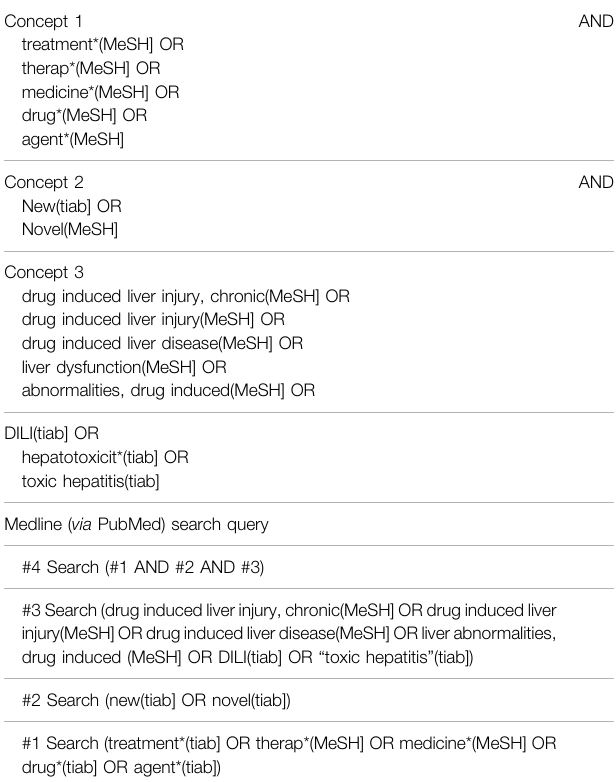
TABLE 1 | Search strategy. Concept 1 AND treatment*(MeSH] OR therap*(MeSH] OR medicine*(MeSH] OR drug*(MeSH] OR agent*(MeSH] Concept